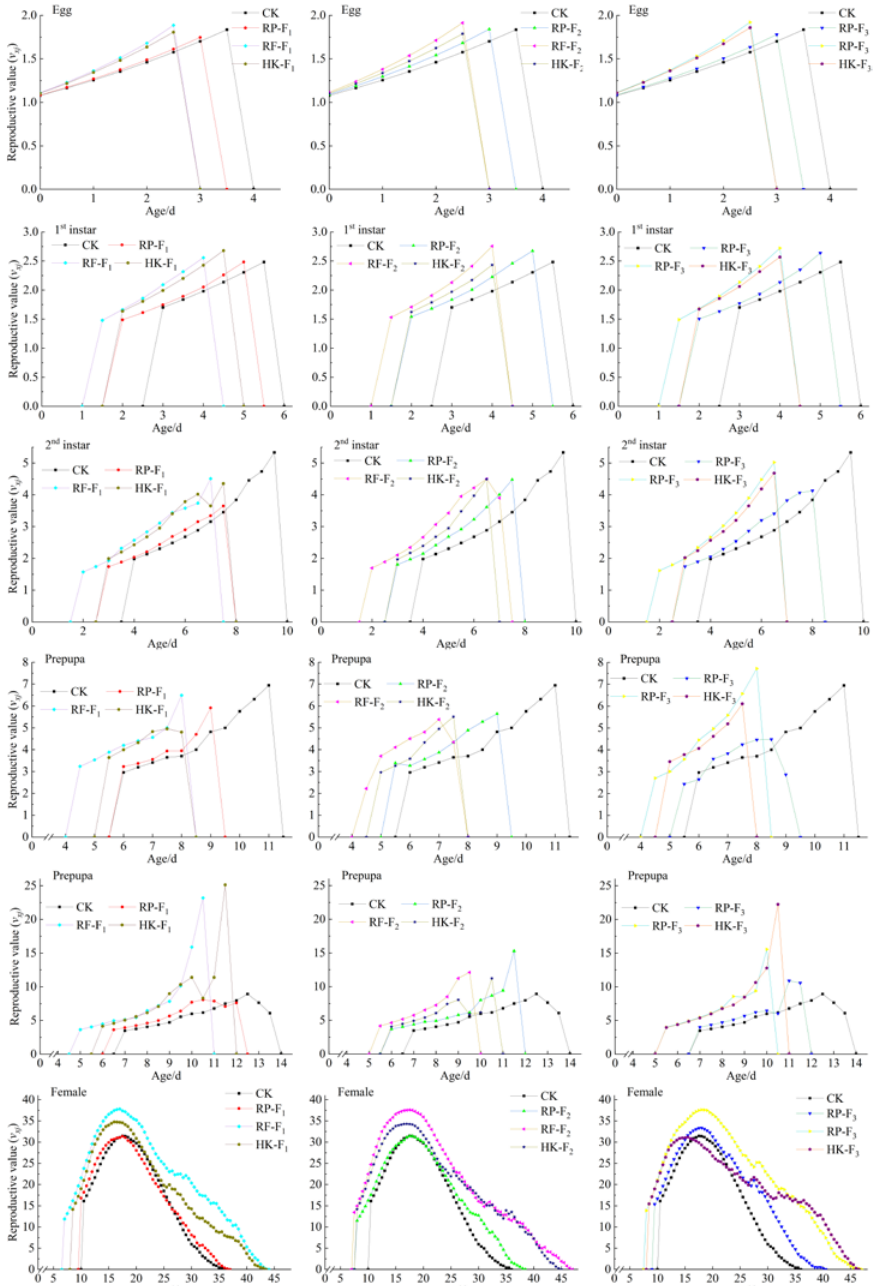
Figure 4. Age-stage reproductive value ( v xj ) of F. occidentalis on different food types in F 1 , F 2 , and F 3